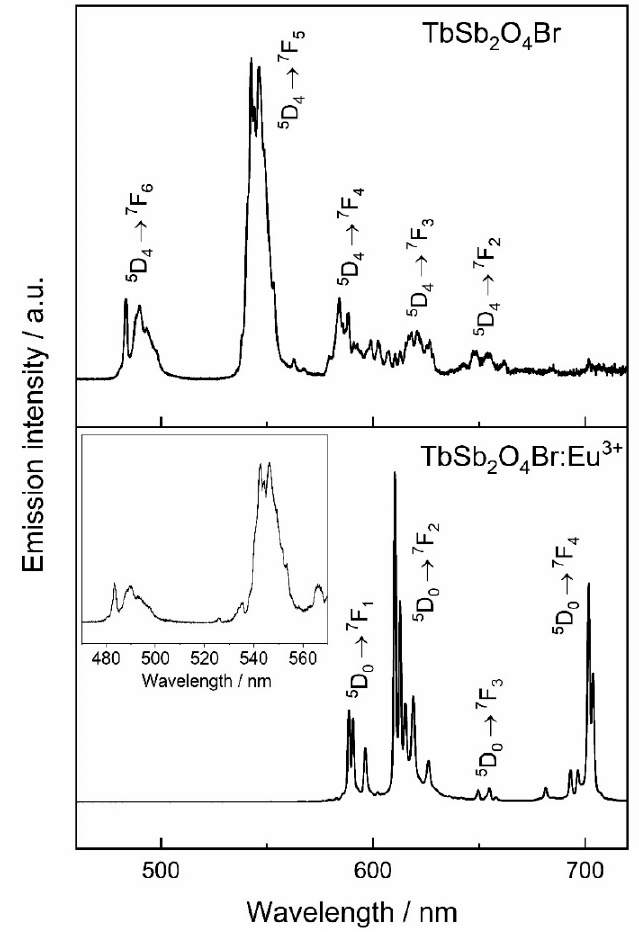
Figure 14. Tb 3+ -based materials upon excitation at 378 nm, corresponding to the 7 F 6 → 5 D 3 transition of Tb 3+ . The inset in the bottom part of the figure shows a magnification of Tb 3+ emission in the Eu 3+ -doped compound TbSb 2 O 4 Br emphasizing the less intense Tb 3+ transitions.